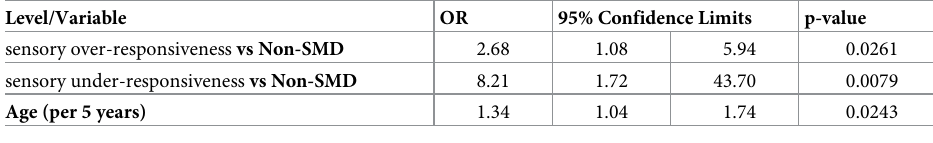
Table 3. Odds-ratios 95% Wald confidence limits and level of significance of risk factors for CRPS (N =